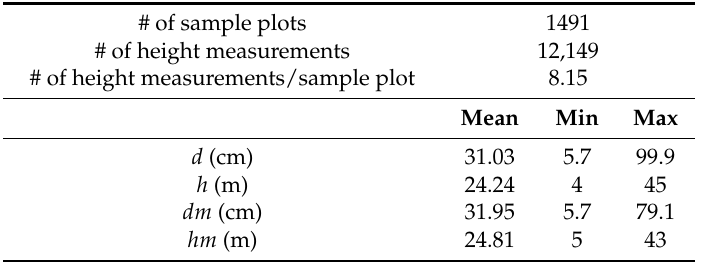
Table 2. Summary statistics of the model data. d = diameter at breast height; h = height; dm = diameter of the median basal area tree per species; hm = height of the median basal area tree per species.